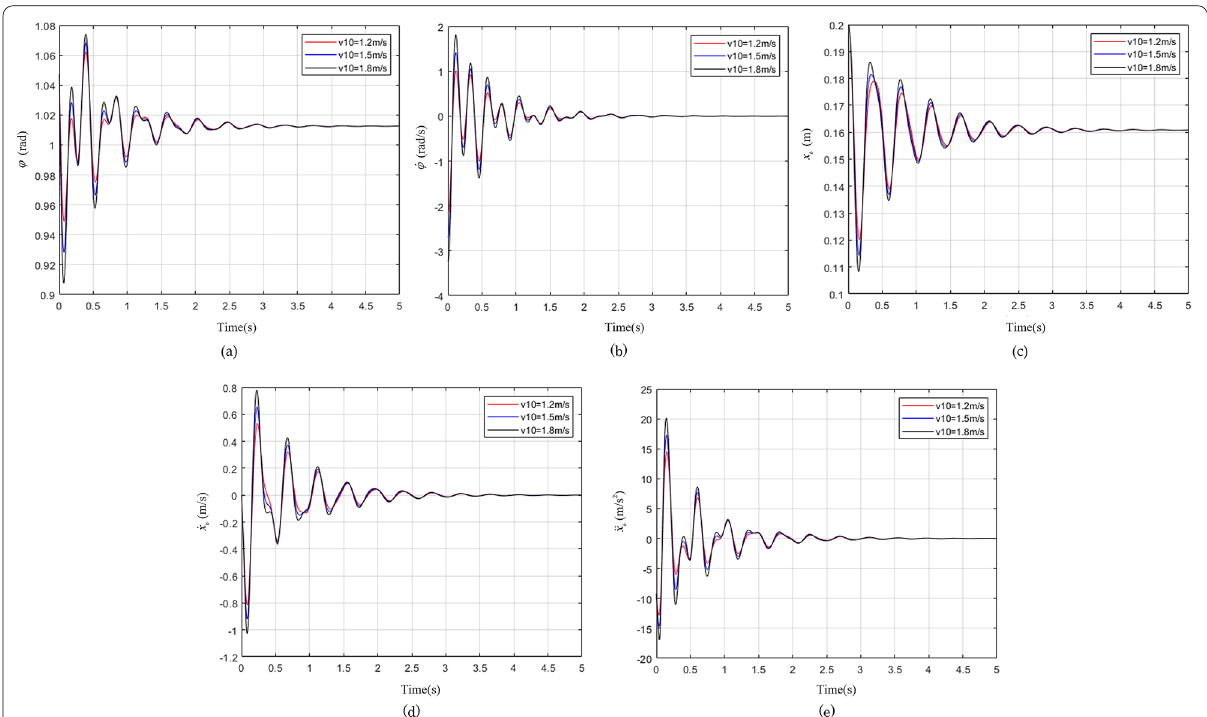
Figure 20 MATLAB results for the variation of a angle ϕ (rad), b angular velocity ˙ ϕ (rad/s), c displacement x b (m), d velocity ˙ x b (m/s), and e acceleration ¨ x b (m/s 2 ) in the multistage buffer